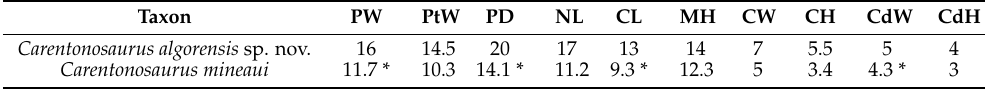
Table 1. Vertebral measurements (in mm) taken for Carentonosaurus algorensis sp. nov (based on its holotype, ALG 200) and Carentonosaurus mineaui (based on its holotype, MNHN IMD 21). Taxon PW PtW PD NL CL MH CW CH CdW CdH Carentonosaurus algorensis sp. nov. 16 14.5 20 17 13 14 7 5.5 5 4 Carentonosaurus mineaui 11.7 * 10.3 14.1 * 11.2 9.3 * 12.3 5 3.4 4.3 *